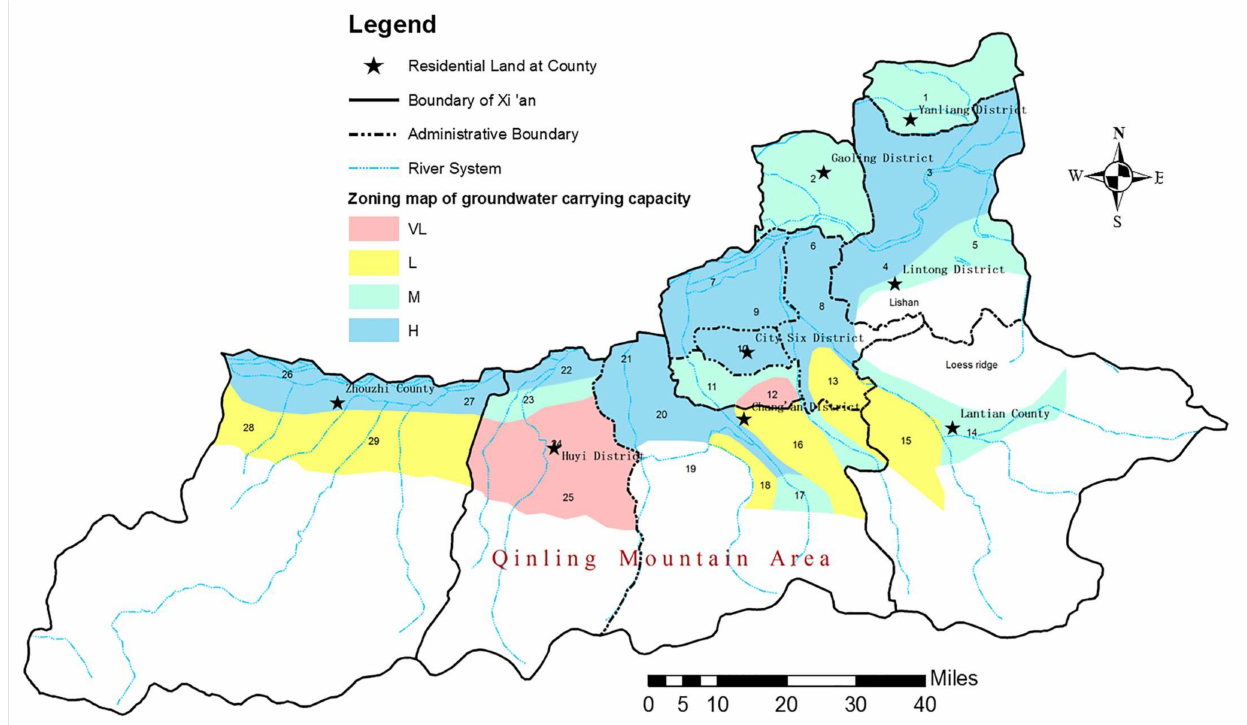
Figure 4. Evaluation results of groundwater carrying